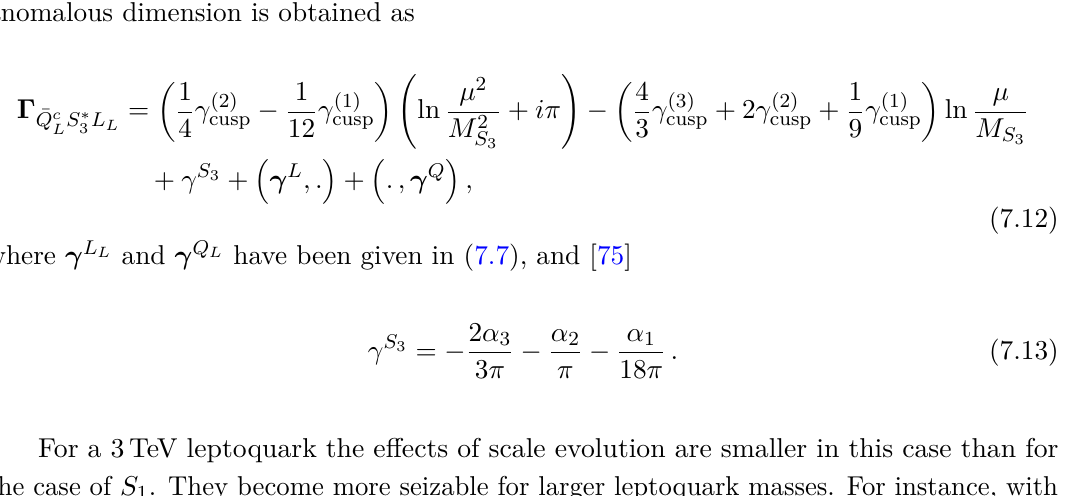
Figure 2 . Resummation effects on the tree-level decay rates for the two-jet decays S 2 / 3 S − 4 / 3 → b L ‘ L , S − 1 / 3 → b L ν L and S − 1 / 3 → t L ‘ L , all of which are governed by the same Wilson 3 3 3 coefficient, as a function of the leptoquark mass M S . The Wilson coefficient is evolved from the scale 3 of the leptoquark mass down to µ = m t . The solid line shows the results of a complete numerical solution of the RG equation, while the dashed curve is obtained by retaining only the cusp terms in the anomalous